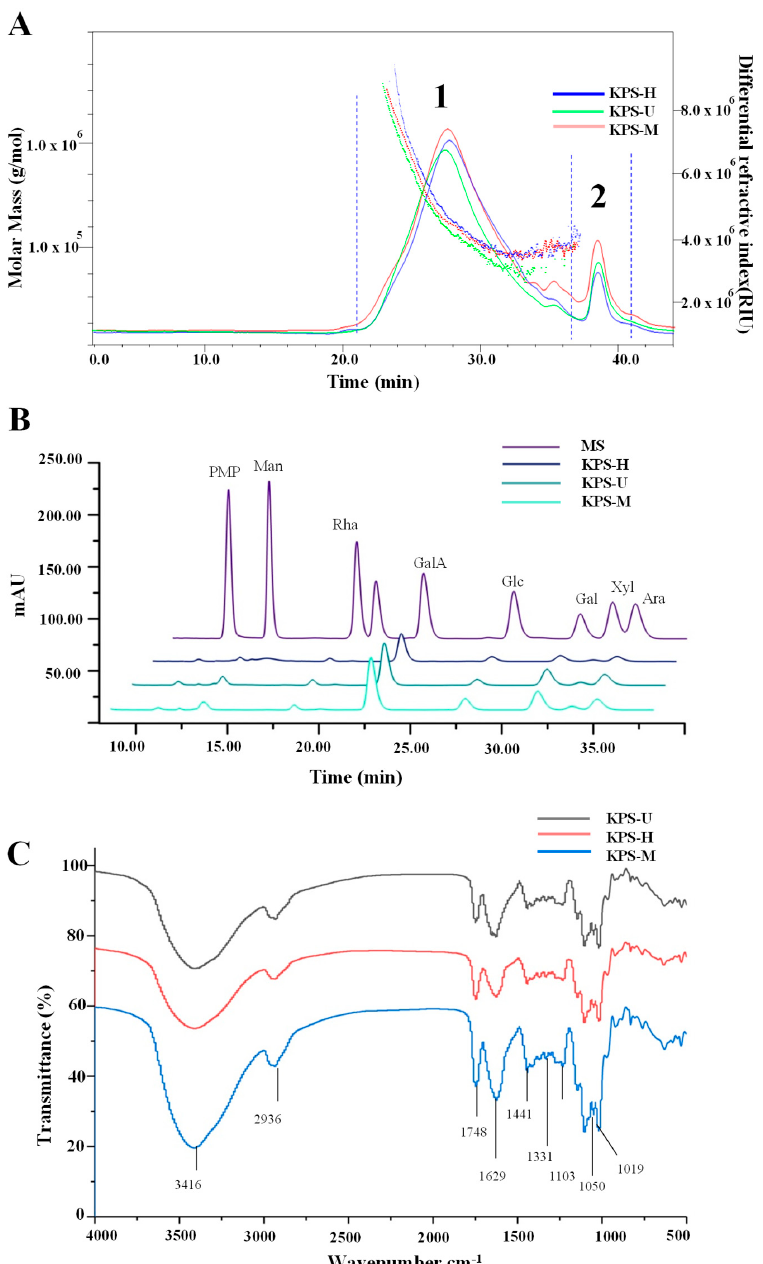
Figure 4. HPSEC chromatograms ( A ), HPLC profiles ( B ), and FT-IR spectra ( C ) of KPS-M, KPS-U, and KPS-H. KPS-M, kiwifruit polysaccharides (KPS) extracted by microwave-assisted extraction; KPS-U, KPS extracted by ultrasound-assisted extraction; KPS-H, KPS extracted by hot water extraction; MS, mixed standard of monosaccharides; Man, Mannose; Rha, Rhamnose; GlcA, Glucuronic acid; GalA, Galacturonic acid; Glc, Glucose; Gal, Galactose; Xyl, Xylose; Ara, Arabinose.